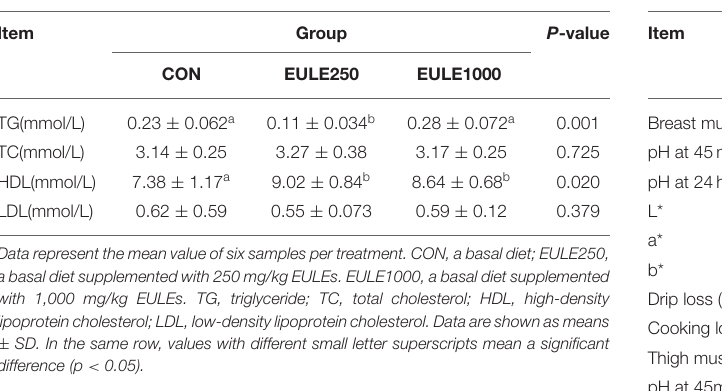
TABLE 5 | Effect of EULEs on the meat quality of broilers.